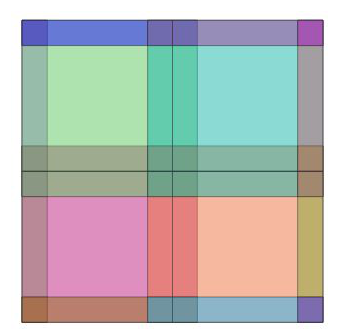
Figure 11. Overlapping tiles for prediction The resulting map is an image where the connections between the tiles are barely visible.